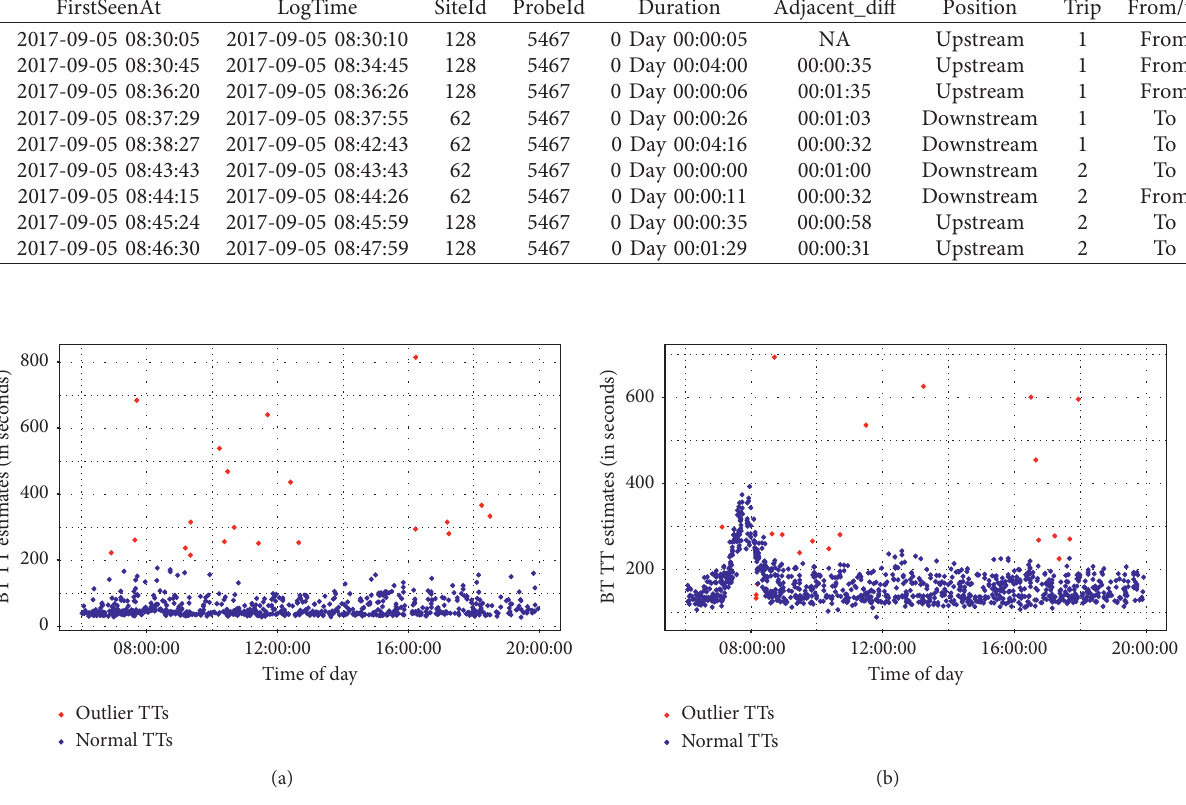
Figure 6: Two examples of running adopted Kalman filter. (a) Link 62-157 on Sep 04, 2017, and (b) Link 90-76 on Sep 12, 2017.